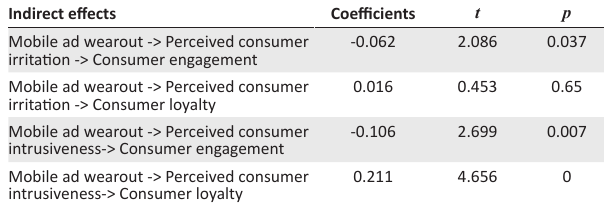
TABLE 6: Indirect effects.